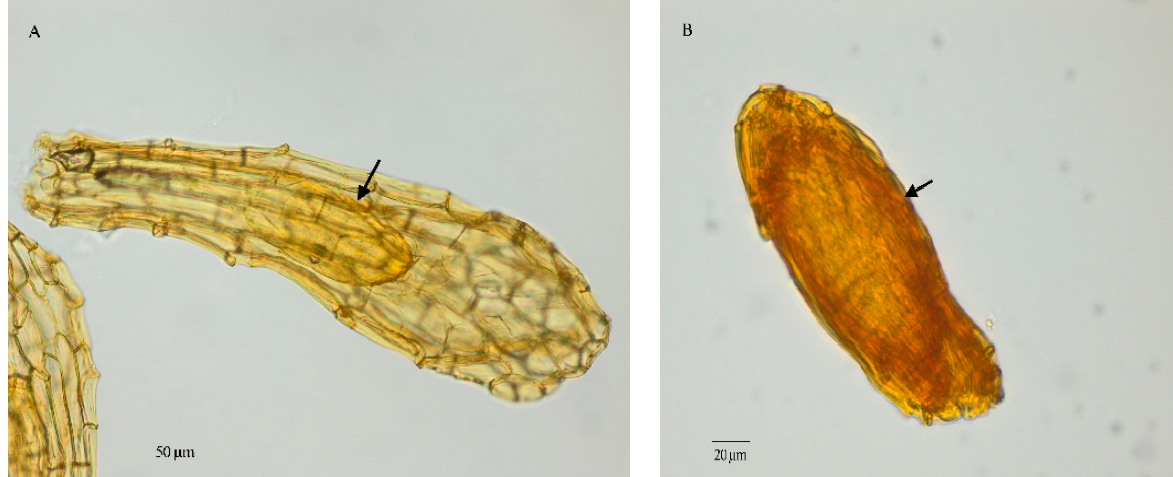
Figure 4. Comparison between the seed and embryo (arrow) under LM for ( A ) Bromheadia finlaysoniana and ( B ) B. cecieliae .